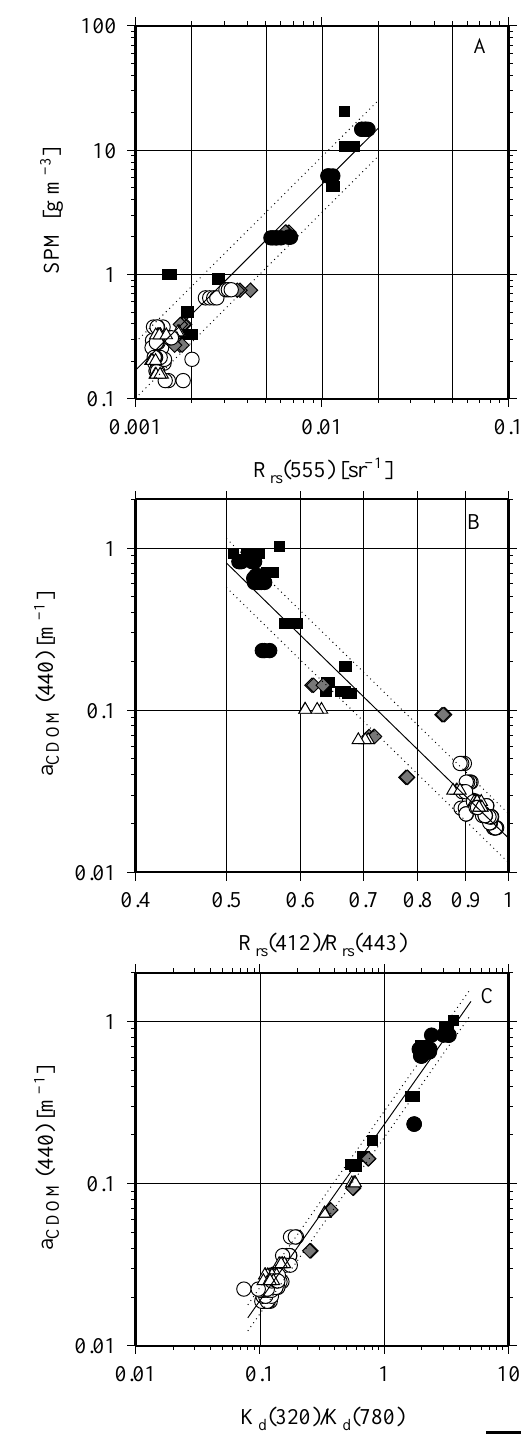
Fig. 9. Bio-optical relationships in the Malina Leg2b data set. Solid curves are regression fits on the log-transformed data, and the dotted 2013 May 30 18:12:45 Fig. 8 curves show the RMSE around the regressions (A) R rs (555)nm as a function of SPM concentration, (B) ratio of R rs (412) to R rs (443) as a function of CDOM absorption at 440nm, and (C) ratio of K d (320) to K d (780), as a function of CDOM absorption at